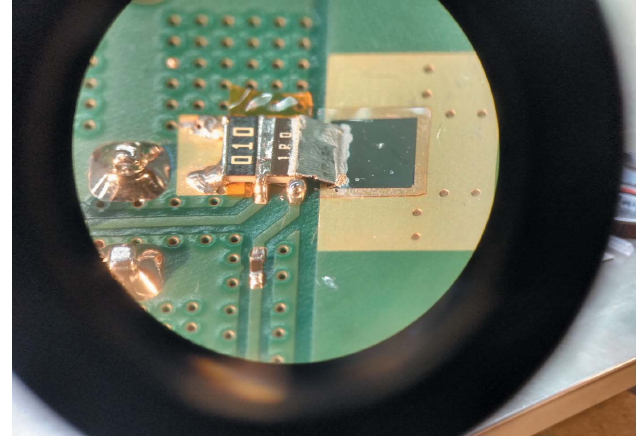
Figure 3 Detail of the readout PCB signal path of the SCIPP assembly, showing the 37 m m-thick diamond sensor, the low-impedance indium band connecting the sensor to the readout network, the series array of 1 (cid:2) and 10 m (cid:2) resistors that shunt the signal to ground, and the two 50 (cid:2) pick-off traces.